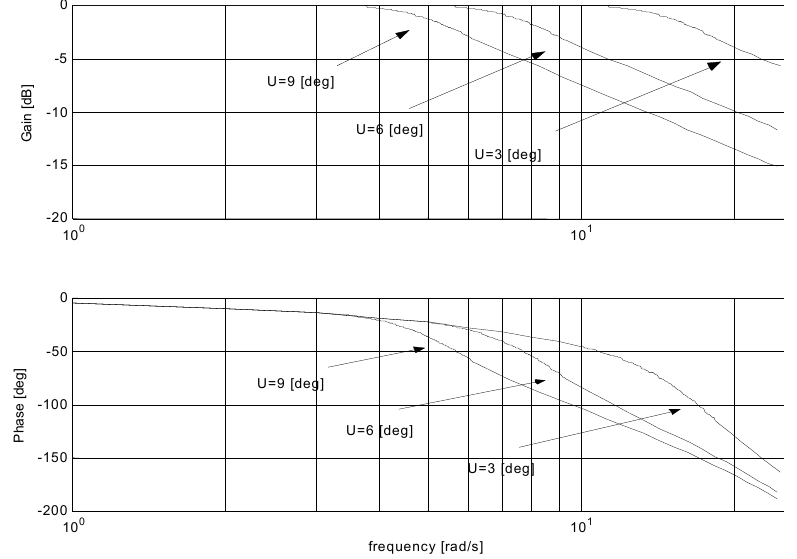
Fig 9 . Freqency characteristics of EMA. Characteristics obtained for three different amplitudes of harmonic input function